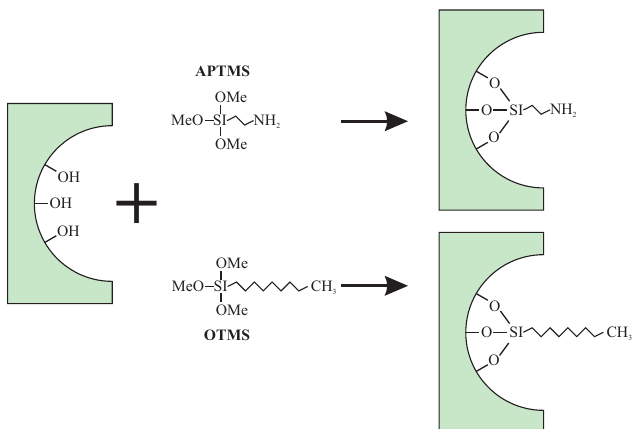
Figure 5. A schematic presentation of the silylation reaction presented in [98] and possible configuration of the SBA-15 after surface modification. Me, methyl